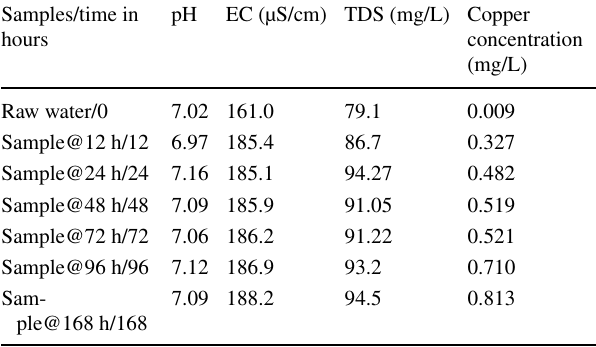
Table 1 Results of copper concentrations, pH, EC and TDS in water samples stored in copper